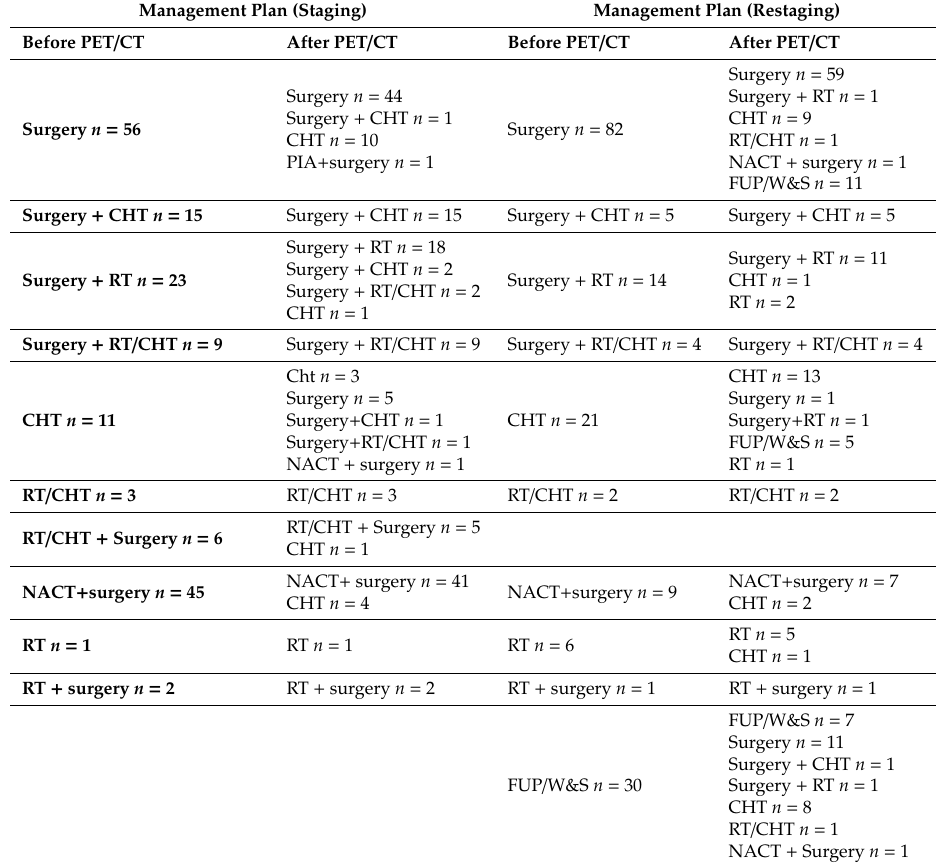
Table 3. Impact of 18 F-FDG PET / CT on the management plan. Management Plan